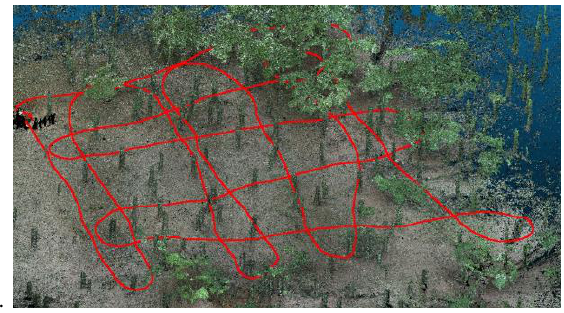
Figure 4. The specific scan path of ZEB HORIZON during the data acquisition